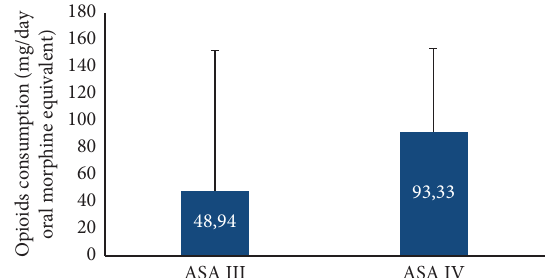
Figure 3: Opioid analgesics consumption in ASA III and ASA IV patients (mg/day OME) ( P <